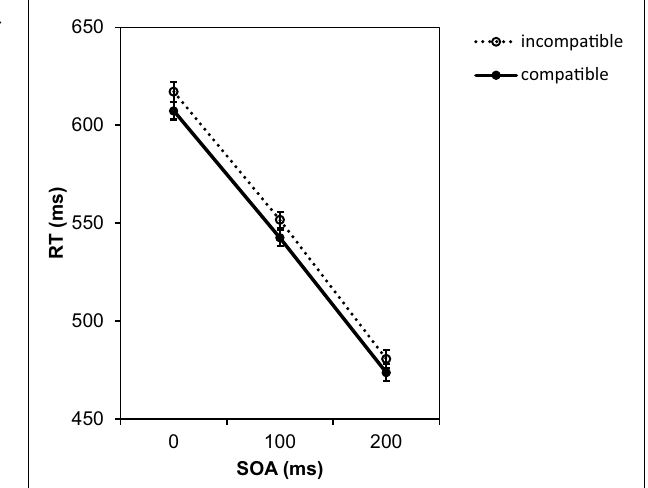
FIGURE 2 | Mean reaction times depending on SOA and compatibility conditions in Experiment 1. Error bars in this and all following graphs represent the standard error of the means calculated for the within-participant design following the procedure suggested by Cousineau